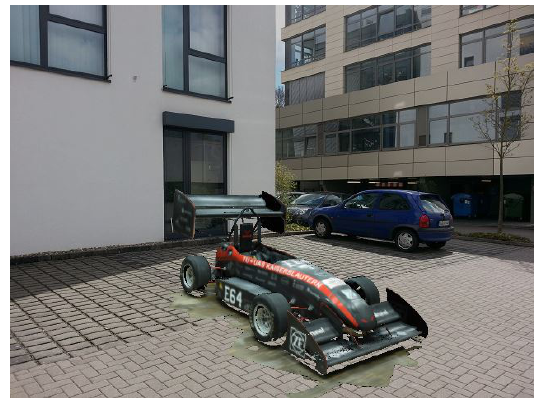
Figure 1: Example of AR application. Virtual car on a real parking